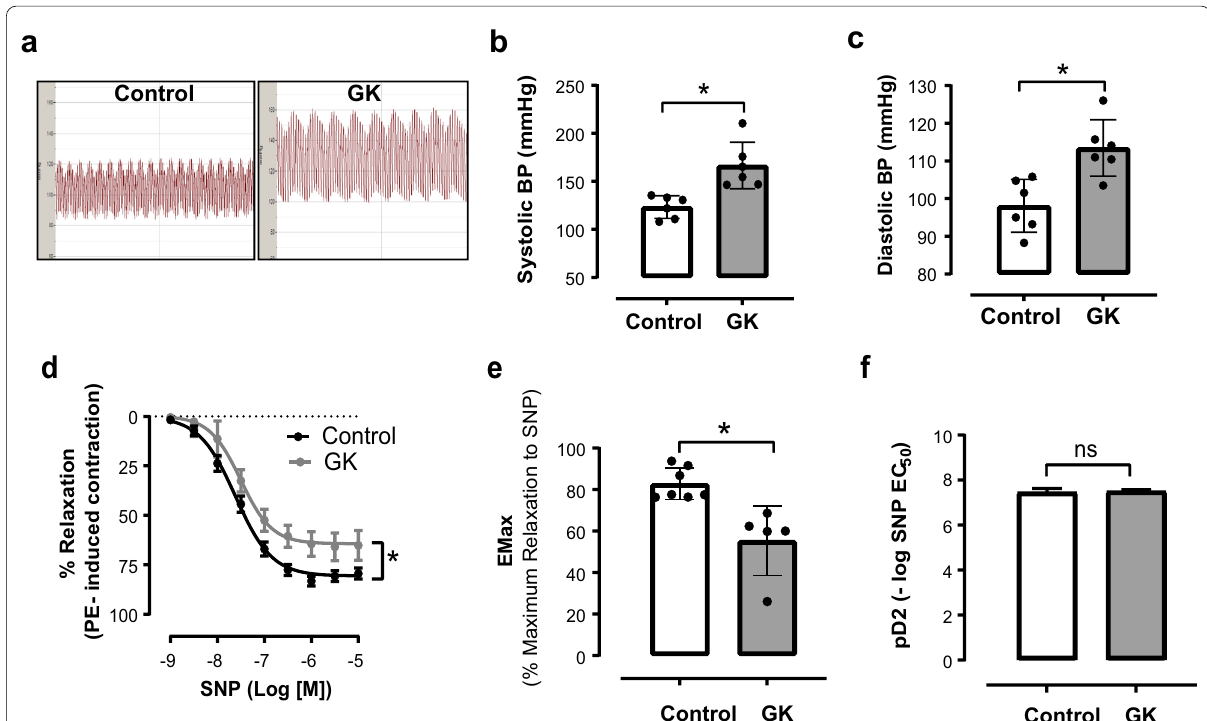
Fig. 2 Increased arterial blood pressure, and impaired VSMC‑dependent relaxation from GK rats in advanced T2DM. a Representative tracing of direct arterial blood pressure (BP) measurement via carotid catheterization. b Systolic BP (mmHg) and c Diastolic BP (mmHg) . d Cumulative concentration–response curves to Sodium Nitroprusside (SNP) in aortas from GK rats (gray circles) in comparison to aortas from age‑matched male Wistar rats (black circles). Each point represents the maximal response to each concentration of SNP, e Maximal relaxation response (Emax) to SNP, f pD2 for SNP curve. *p < 0.05 vs. control, n 6 per group. Values are means = ±